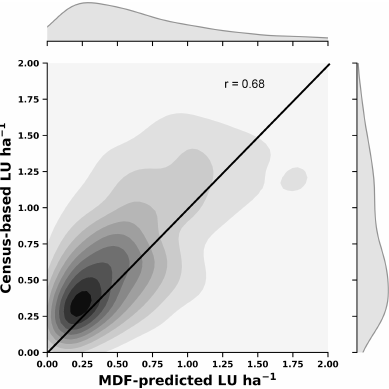
Figure A3. Kernel density estimates plot (inner part) and distributions (outer part) of MDF-predicted ( x axes) and census-based ( y axes) livestock